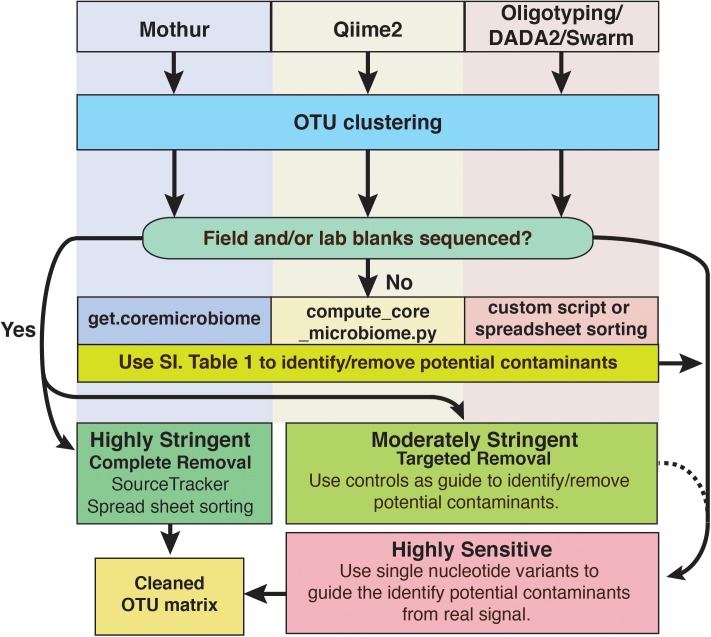
Schematic diagram of options to identify and remove contaminant amplicon reads from sequencing datasets. Because several options are available and are being developed continually, we suggest these methods are not comprehensive and depending on the dataset may not be suitable. However, we hope that this serves as a guideline for approaching contamination removal.